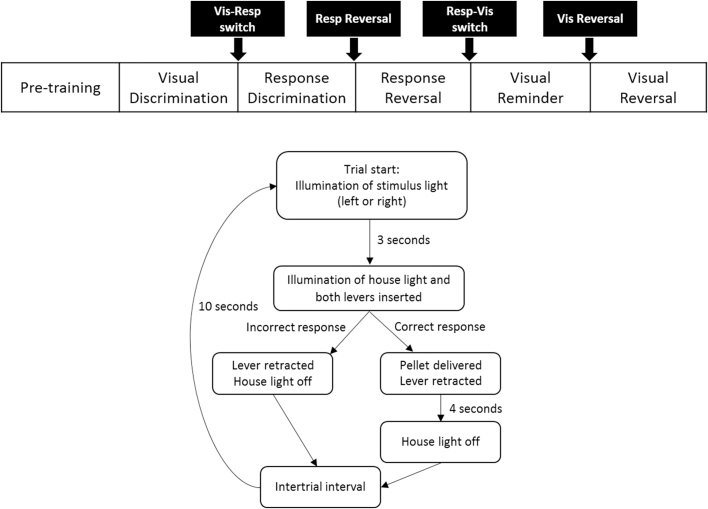
Strategy-shift task (Experiment 2). Schematic showing the order of the discrimination stages and basic trial structure for the strategy-shift task. The black boxes show the points at which a new discrimination strategy was introduced.